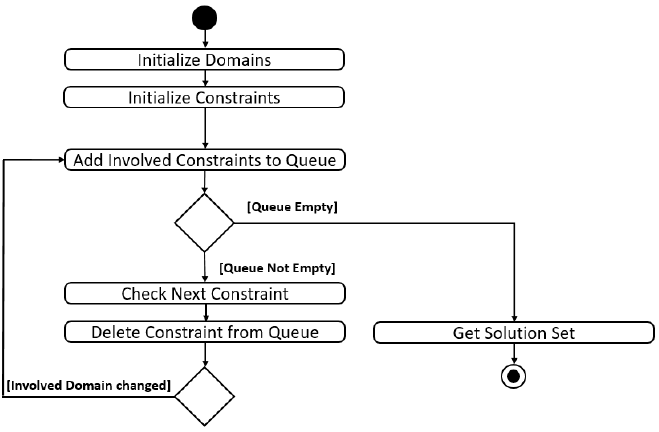
Figure 5. Activity diagram for constraint